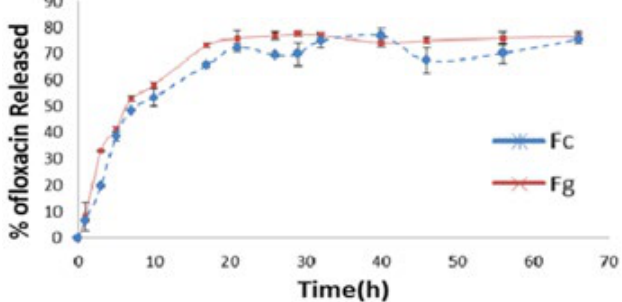
FIGURE 6 - In vitro release profile of ofloxacin from Chitosan/ TPP nanoparticles (Fc); Chitosan/TPP-Alginate nanoparticles (Fg). Release assay was performed in PBS solution, pH: 7.4, at 37 °C with agitation